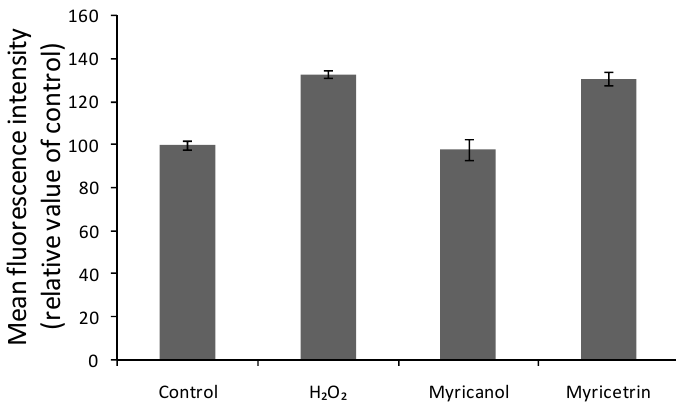
Figure 7. Effect of myricanol and myricetrin on intracellular ROS in N2a cells. Myricanol and myricetrin at the concentration of 0.84 mM and 0.65 mM, respectively.